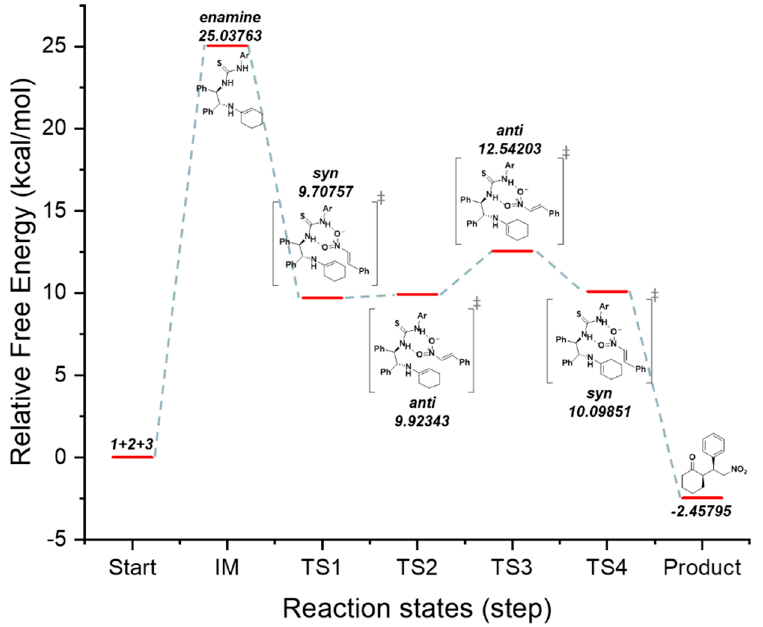
Figure 1. Proposed catalytic mechanism based on B3LYP/6-31G(d,p) calculations and the free en- ergy diagram of the ( R , R )-1,2-diphenylethylenediamine(DPEN)-thiourea-catalyzed enantioselec- tive Michael